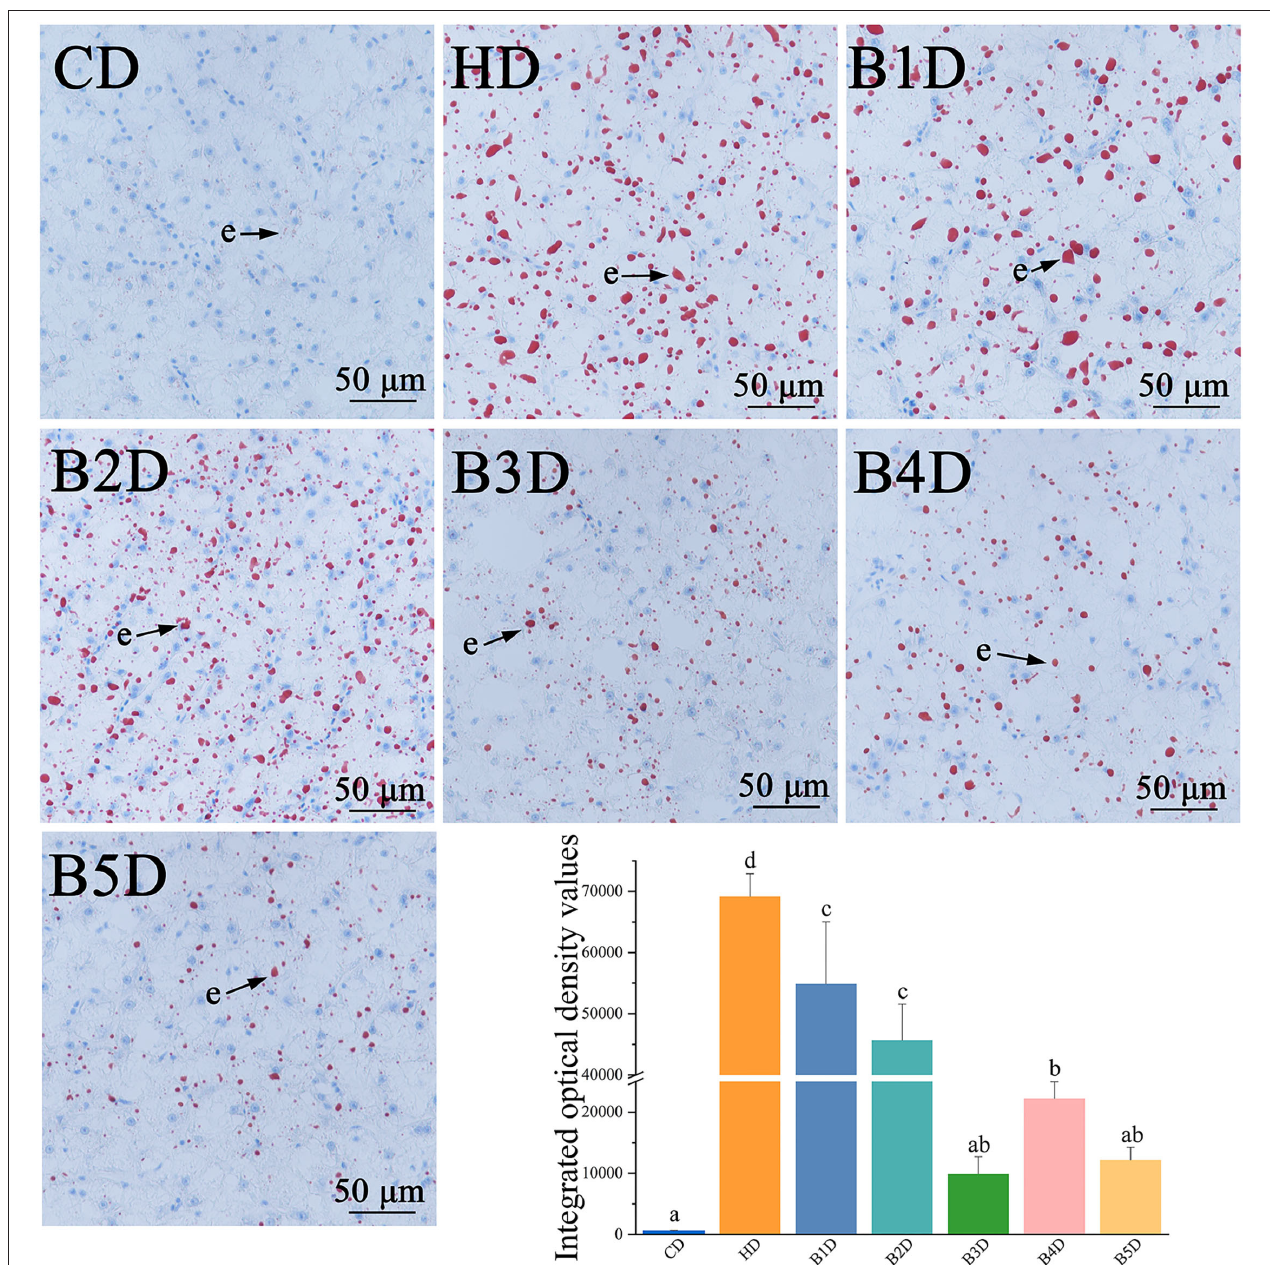
FIGURE 2 | Photomicrographs of representative oil red O-stained histological liver sections of fish from HD and BD groups. e: lipid droplets are stained red and analyzed by integrated optical density ( n = 4), and the nuclei are stained blue in oil-red O-stained sections. Values are presented as means with SD, where significant ( p < 0.05) differences between groups are indicated by different